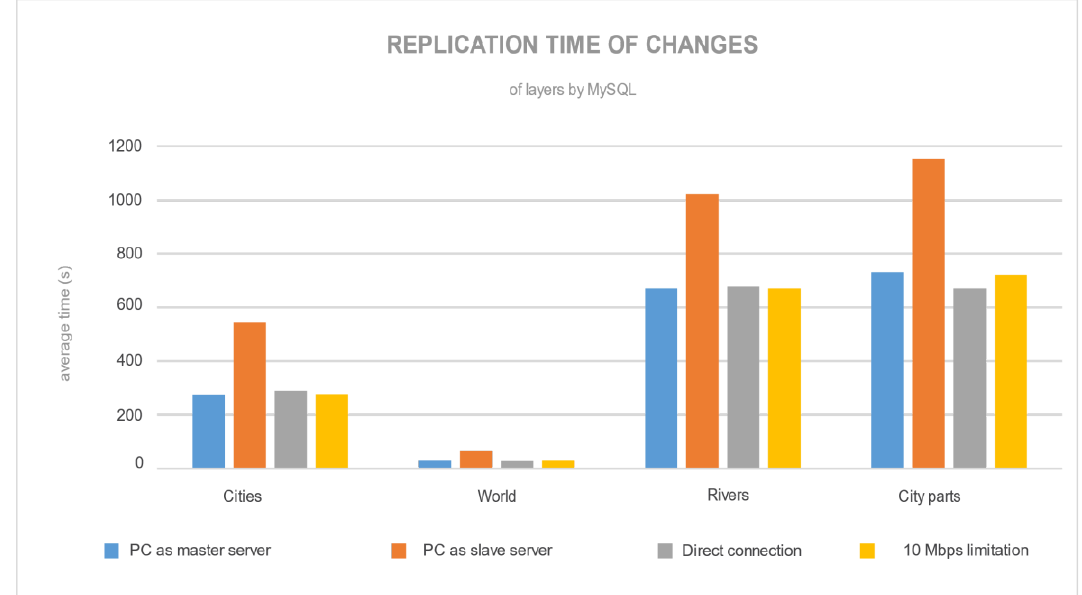
Figure 14. Average replication time of layers with different cluster configuration by MySQL.